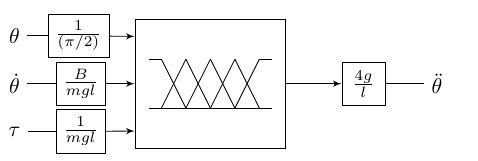
Figure 26. Simple pendulum input and output scaling